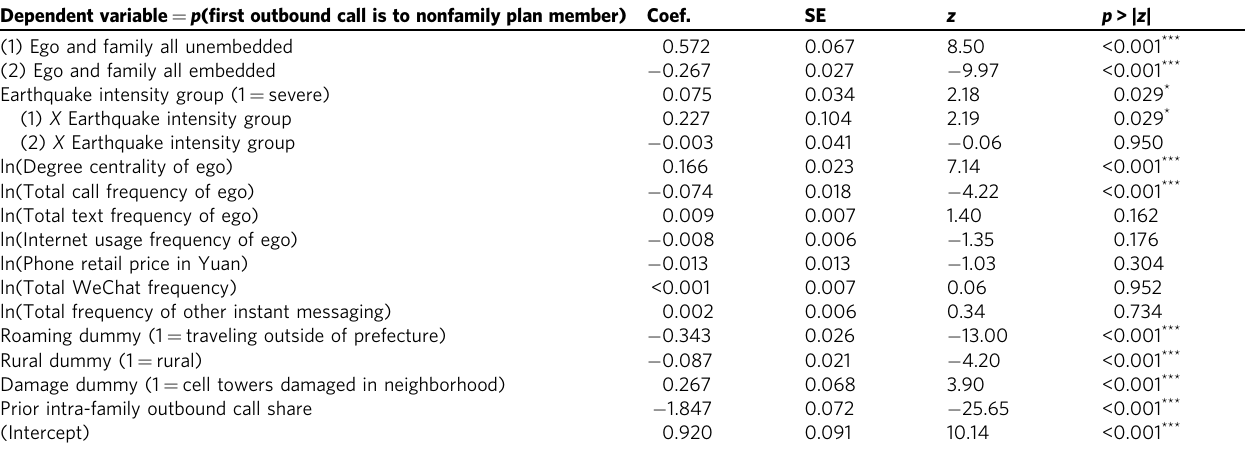
Table 1 Target of initial outbound calls.